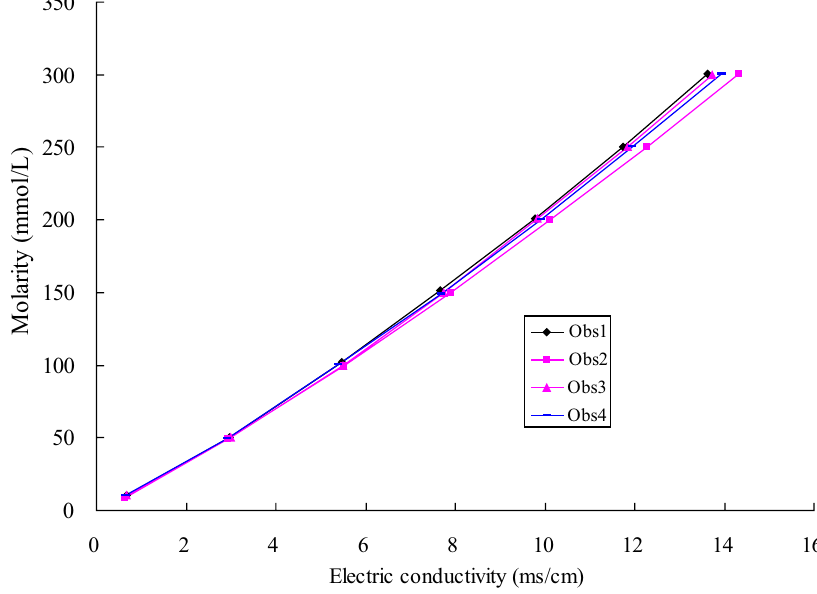
Figure 3. Relationship between molar concentration and electric conductivity of each salt sensor.